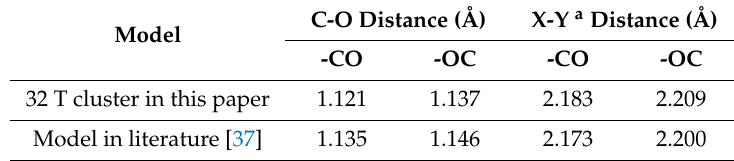
Table 2. Structural parameters of CO adsorbed on the 32 T cluster of the HZSM-5